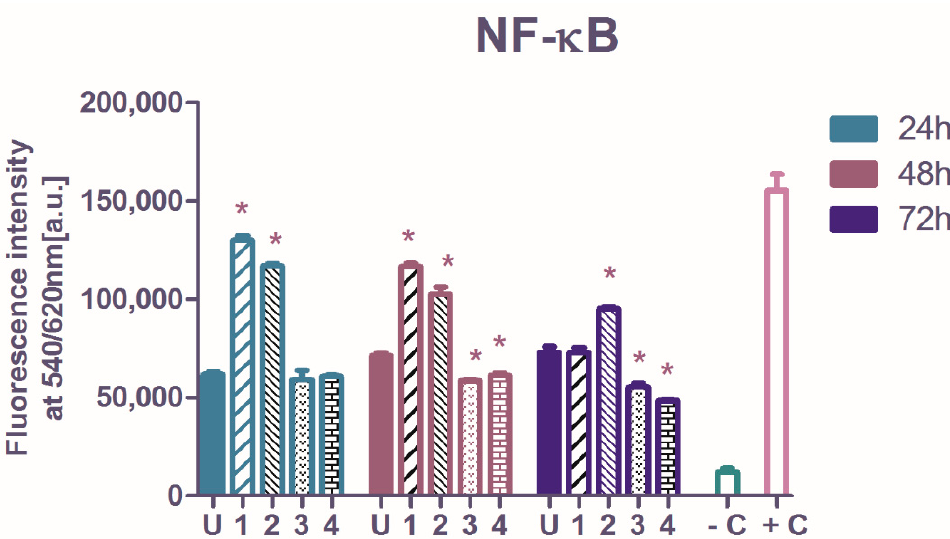
Figure 3. The semiquantitative evaluation of the ruthenium complexes influence on total intracellular NF- κ B p65 transcription factor activated in ovarian cancer cells after 24-, 48- or 72-h treatment; the starred columns indicate a significant increase or decrease versus the untreated cells’ NF- κ B level. In each interval, the symbol U represents the untreated cells, while 1 – 4 represents the treated cells. The negative control ( − C ) was the fluorescence intensity developed by the cell lysis solution, while the positive control ( +C ) was a reference protein derived from stimulated cells (as described in Section 3). Starred columns represent the significant changes versus the untreated control.